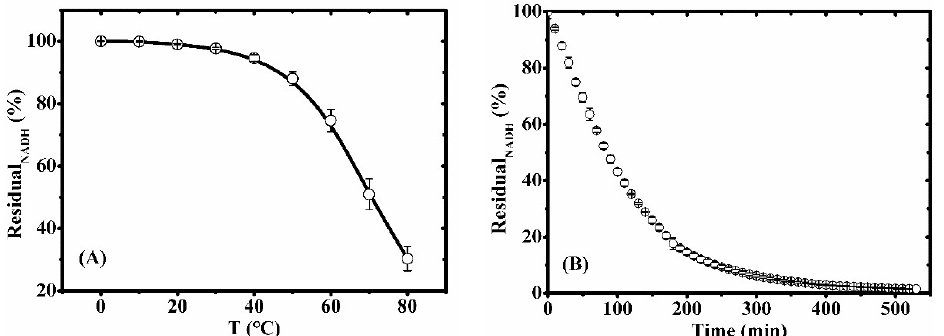
Figure 1. Study of the degradation of NADH in the presence of BmimBF 4 . ( A ) Temperature-course plot (time interval: 10 min); ( B ) Time-course plot of degradation at 37 ◦ C; General conditions: NADH (1.4 mg, 2 µ mol); BmimBF 4 (2 µ L, 5.0 equiv.); H 2 O (2 mL).